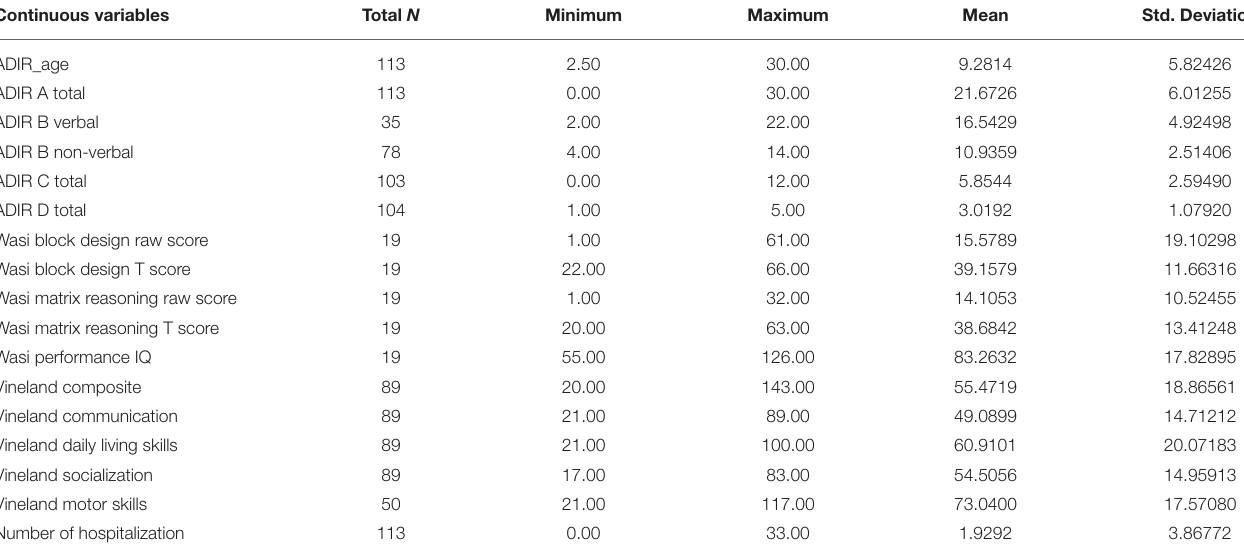
TABLE 1 | Descriptive parameters of continuous variables.